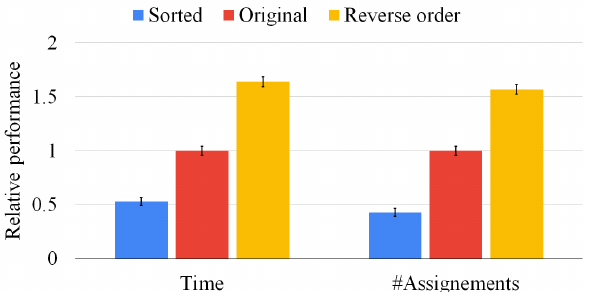
Figure 10. Our sorting heuristic against the state-of-the-art order and the reverse one on graph pairs of random size. We report the mean resolution time (on the left-hand side) and the average number of vertex pairs checked (on the right-hand side) normalized with respect to the original method. The standard deviation of the ten runs is reported on top of each